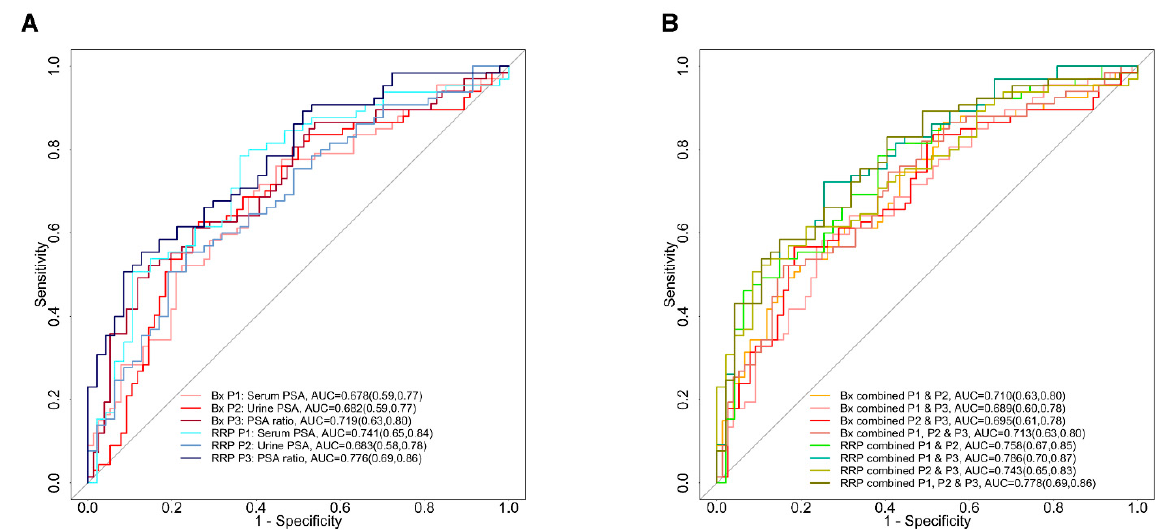
Figure 5. Performance of serum and urine PSA alone and with ratios across different Gleason scores. The ROC curves for the biopsy (Bx) or radical prostatectomy (RRP) serum or urine PSA to predict the AG disease. Comparing the urine to serum PSA and the ratio of serum to urine PSA demonstrated that serum to urine PSA ratios had the best performance in terms of AUC analysis, i.e., AUC = 0.719 and AUC = 0.776 in Bx and RRP specimens, respectively. Their combinatory approach ( B ) demonstrated that none of the combinations of the ROC curves between serum or urine PSA assays were superior to the ROC curves that were constructed for the ratio between serum to urine alone. Numbers in parentheses represent the 95% (CI) confidence intervals for each group ( A , B ).